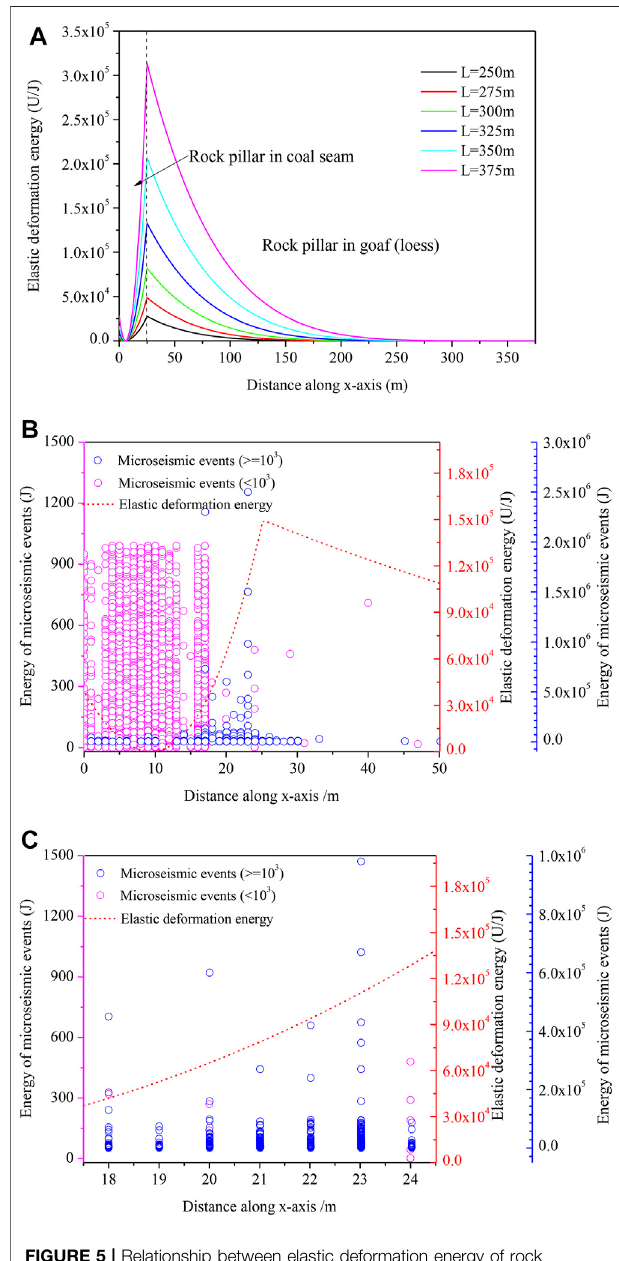
FIGURE 5 | Relationship between elastic deformation energy of rock pillar and microseismic activity. (A) Variation curve of the elastic deformation energyoftherockpillaralongthexaxiscoordinatedirection; (B) microseismic energy distribution at 0 – 50 m above the working face; (C) microseismic energy distribution at 18 – 25 m above the working